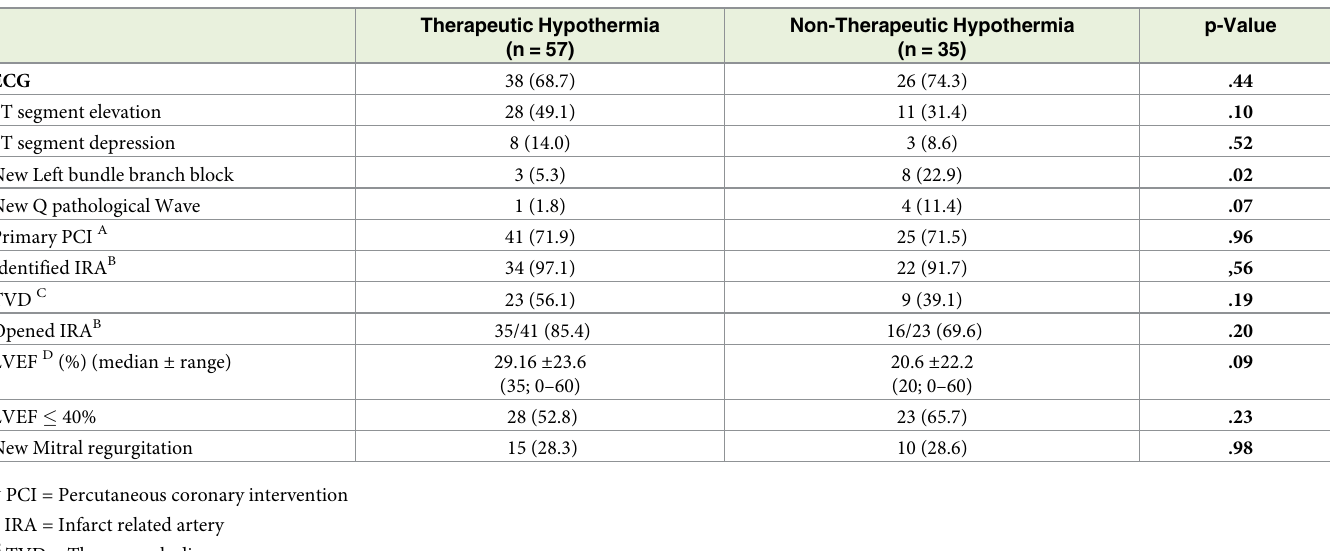
Table 2. ECG, echocardiographic and coronary angiography